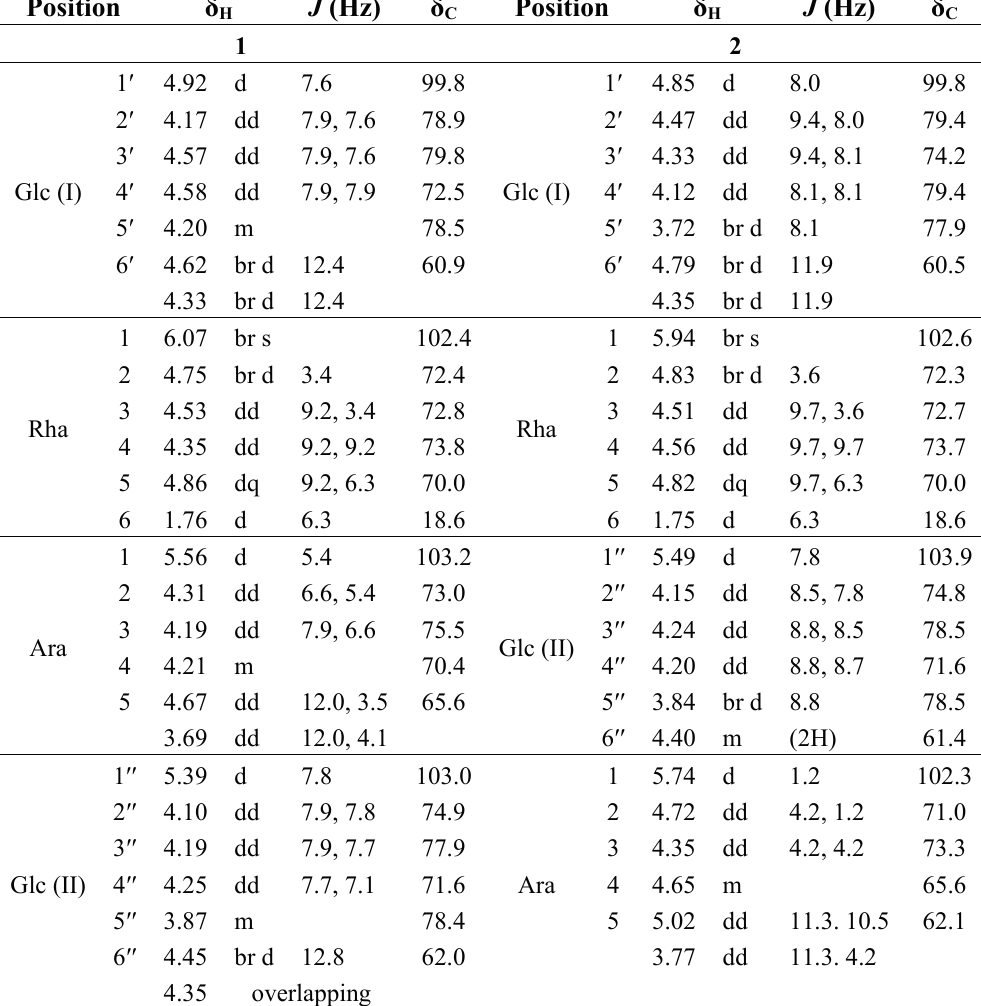
Table 2. 1 H- and 13 C-NMR spectral assignments for the sugar moieties of 1 – 4 in C 5 D 5 N.